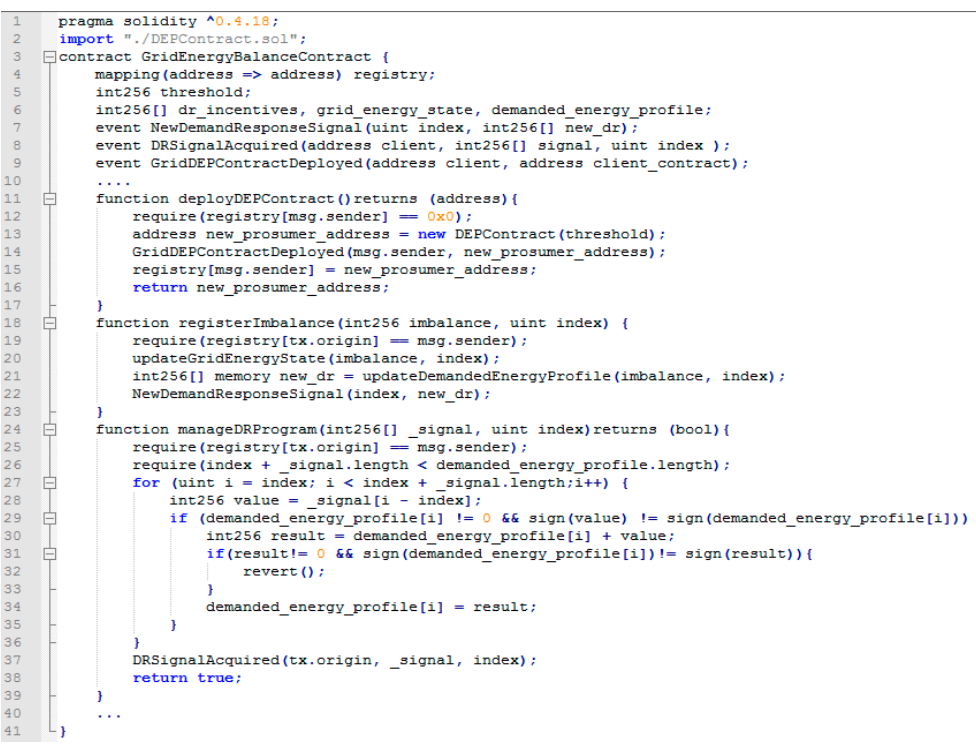
Figure 6. Code excerpt from the smart contract managing the grid energy balance.